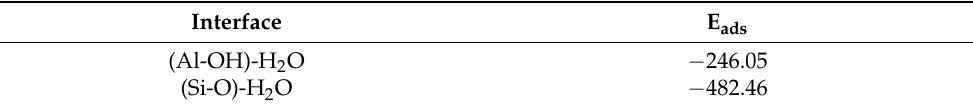
Table 2. Adsorption energies of rare earth Y(III) on the (Al-OH)-H 2 O and (Si-O)-H 2 O interface (units: kJ/mol).